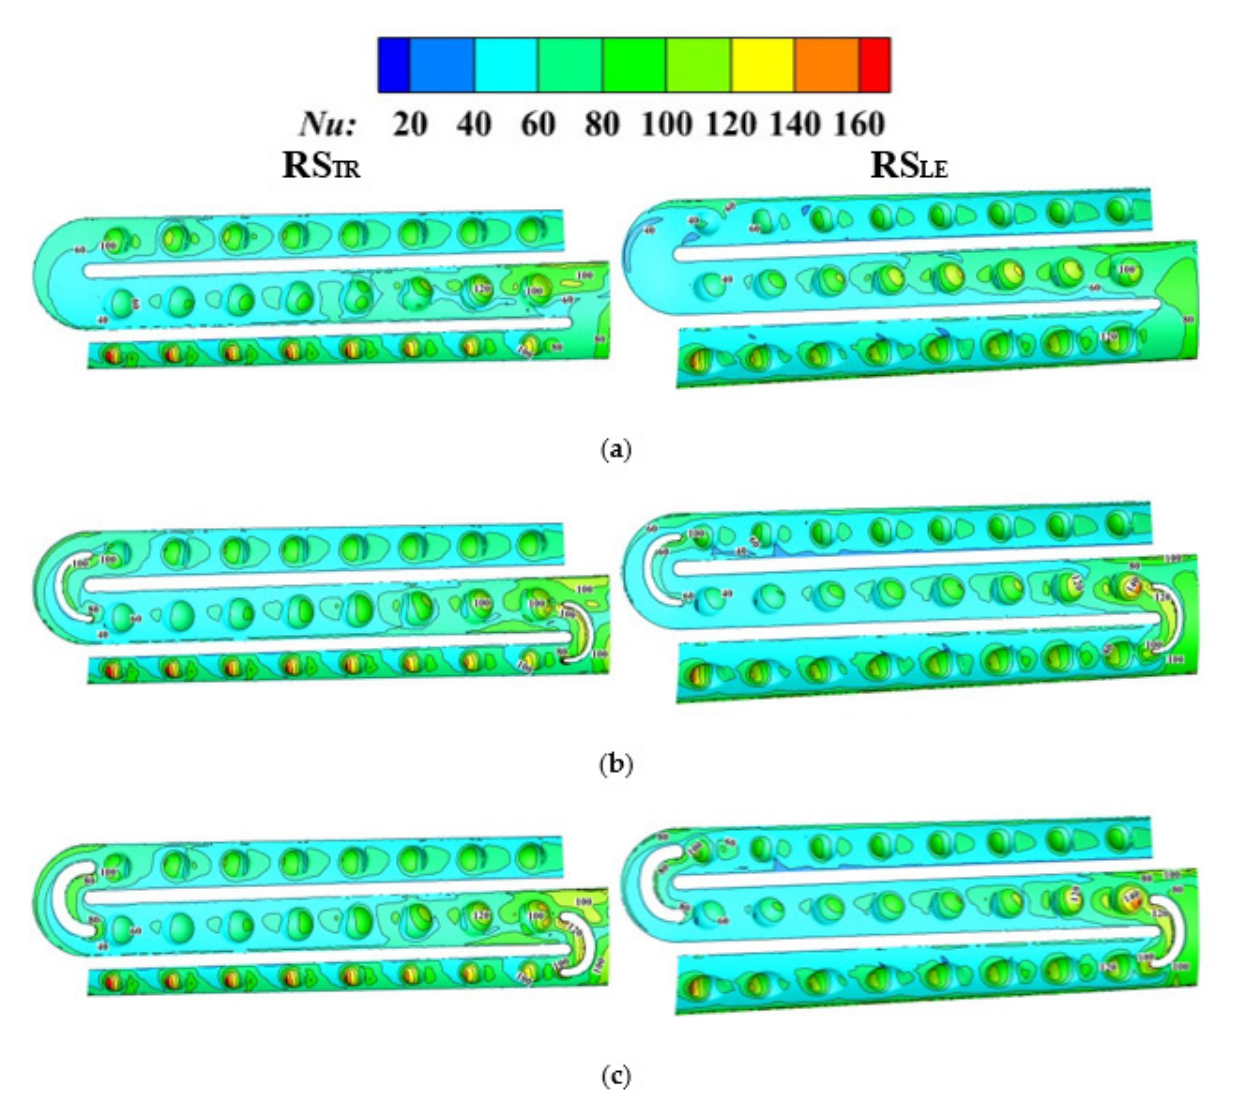
Figure 15. The Nu counters, Ro = 0.4: ( a ) case1; ( b) case3; ( c ) case5.